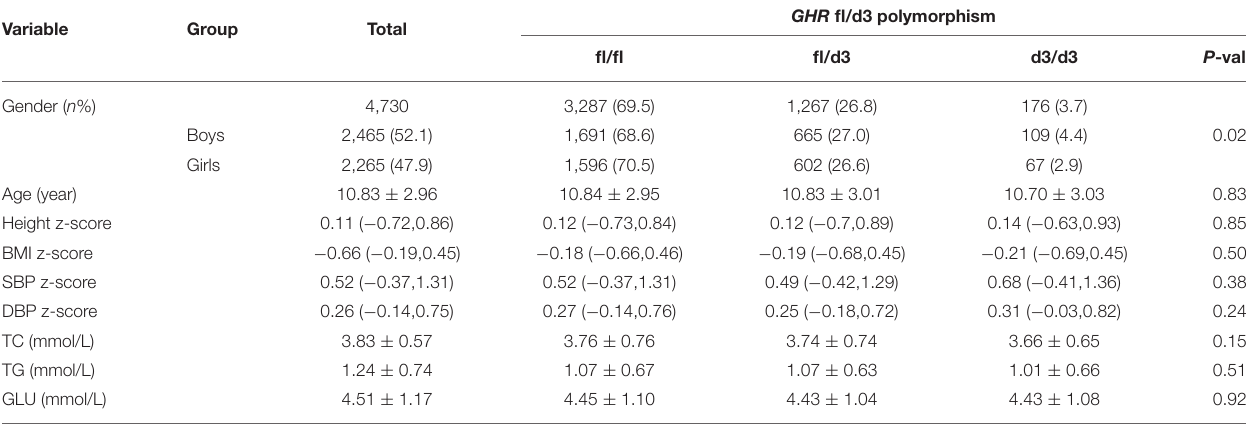
TABLE 1 | Demographic and clinical characteristics for the participants. Variable